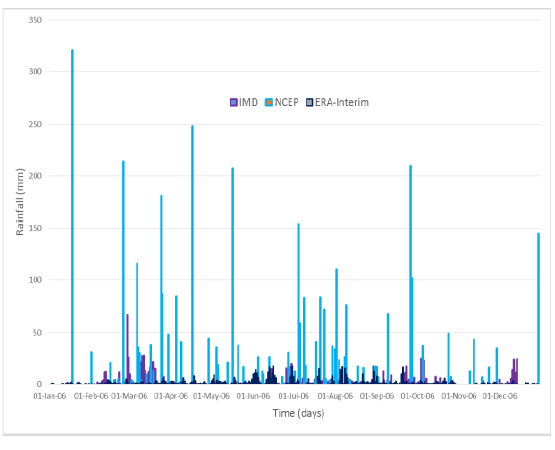
Figure 4.6. Comparison of rainfall data sources for year 2006 (IMD, VIC-global and ERA-Interim) for entire Beas